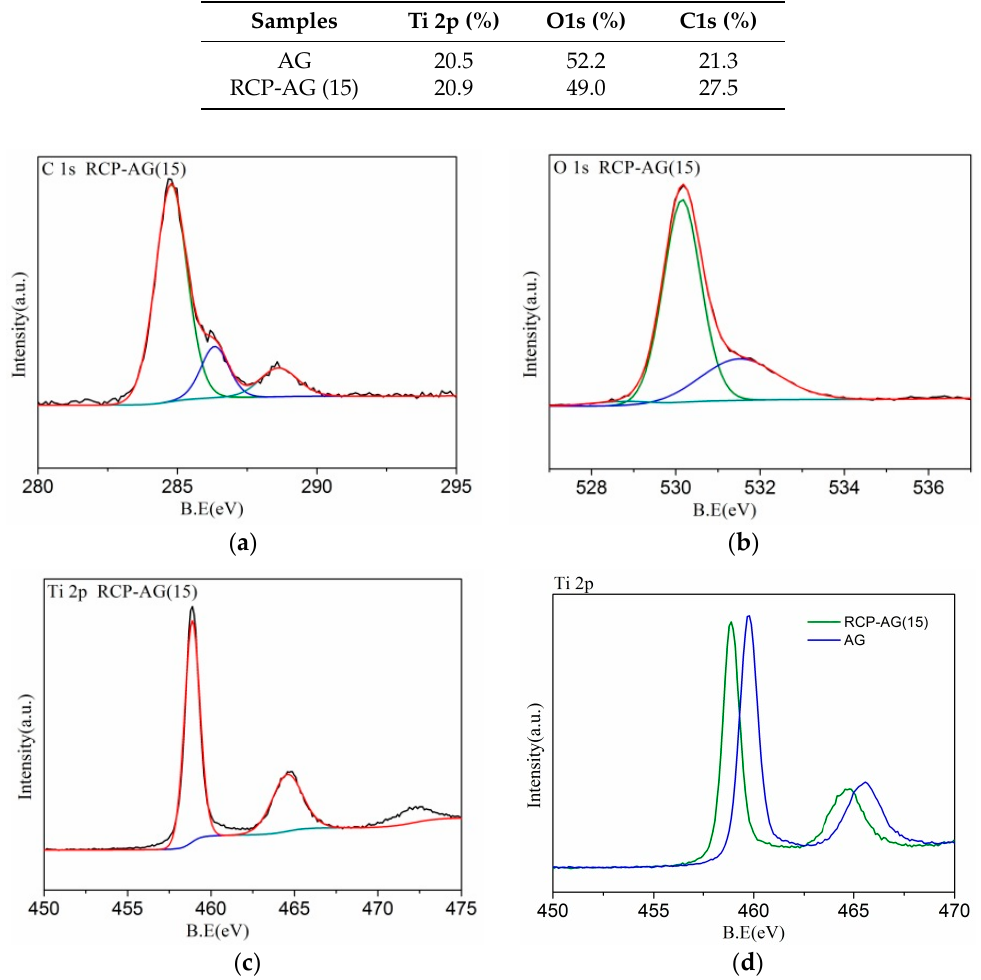
Table 2. The surface element composition obtained from XPS analysis.